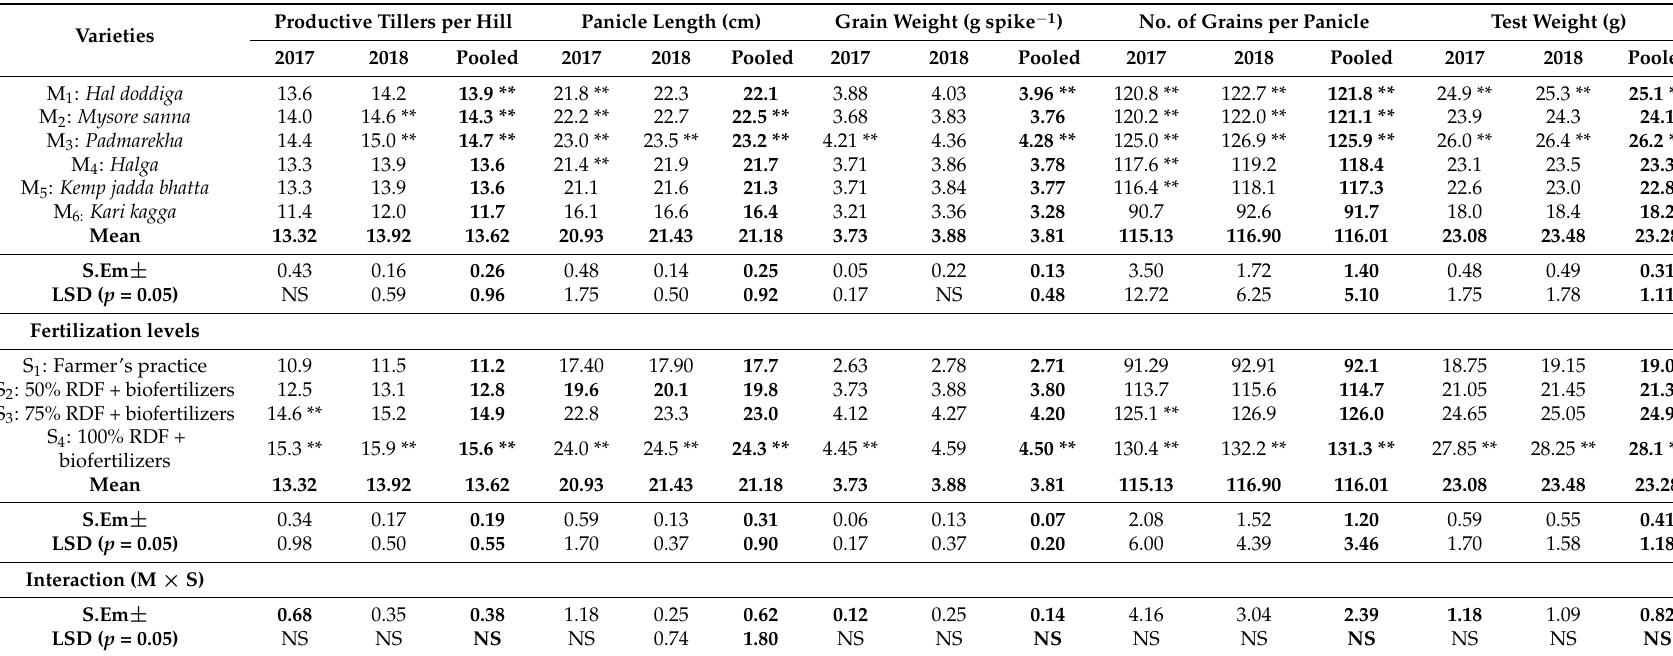
Table 2. Yield attributes of traditional paddy landraces as influenced by different fertilizer levels in conjunction with biofertilizer practices in coastal areas of Kumta Taluk, Uttara Kannada district, Karnataka,